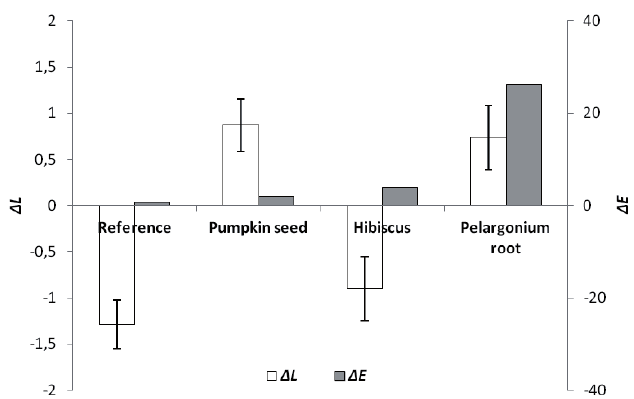
Fig. 3: Browning after 4 h measurement and total colour change at zero time (directly after dipping) of apple-fresh-cuts treated with sodium bisulfite (reference) compared to pumpkin seed, hibiscus and pelargonium root extract. Vertical bars represent standard deviation of the means (n =